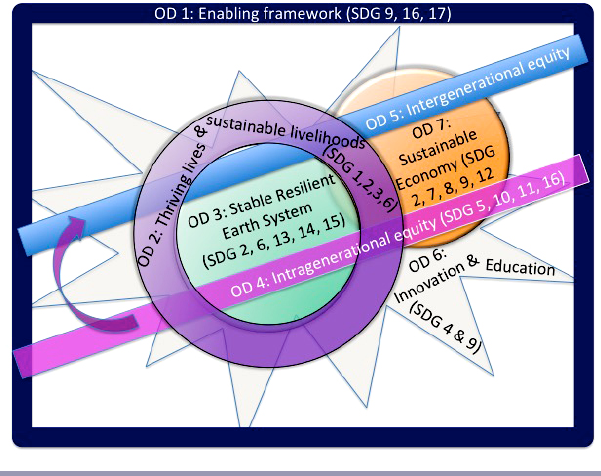
Fig. 4. Required relationships among the seven overarching directions to orient the SDG system toward the sustainable development end goal: at the core, a stable resilient Earth system (OD3) is the foundation for thriving lives and livelihoods (OD2). This influences and is influenced by a sustainable economy (OD 7). Innovation and education (OD6) are required to facilitate integration across the economic, social, and ecological components of sustainable development and to develop mechanisms to simultaneously advance all three components. This is mediated and regulated by an overarching enabling framework (OD1). To achieve the sustainable development end goal intragenerational (OD4) and intergenerational (OD 5) equity need to be included in the implementation of all other ODs, including OD1. Intragenerational equity (OD4) contributes to future intergenerational equity